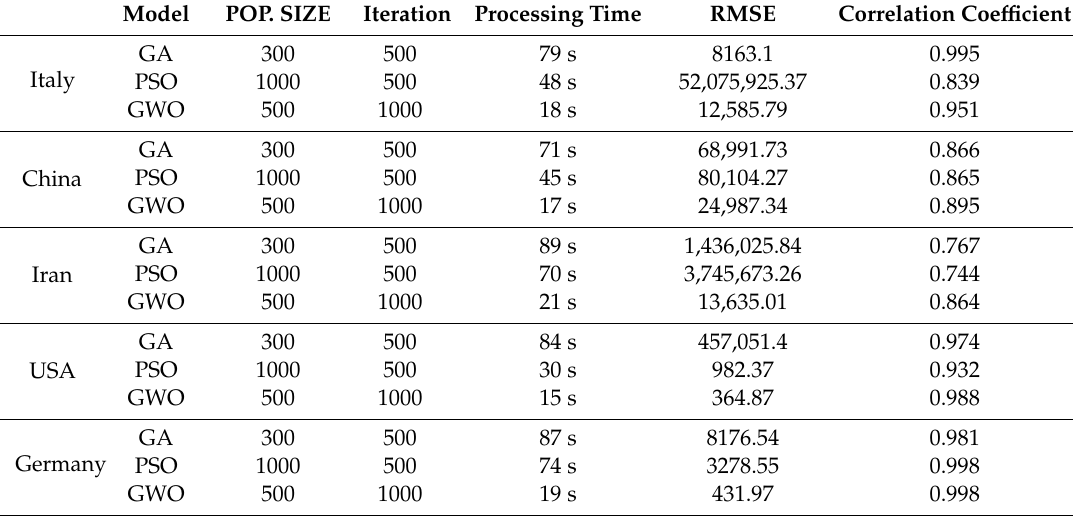
Table 10. Accuracy statistics for the exponential